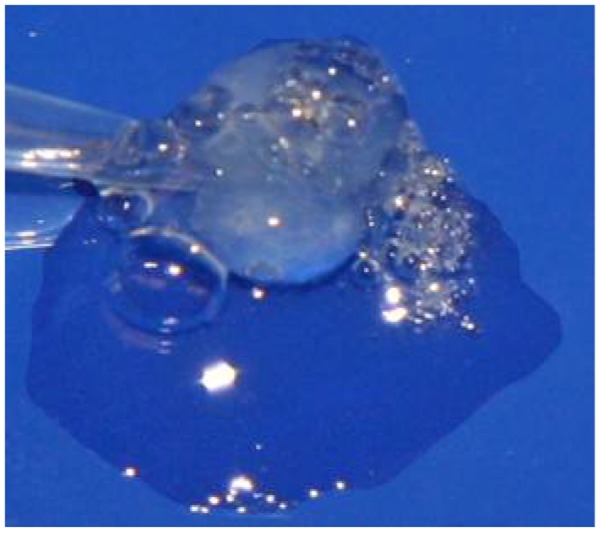
Fibrin plug model.Thrombin and fibrinogen solutions, combined here on the bench top, form gelatinous fibrin plugs that retain the bacteria in the distal airways.